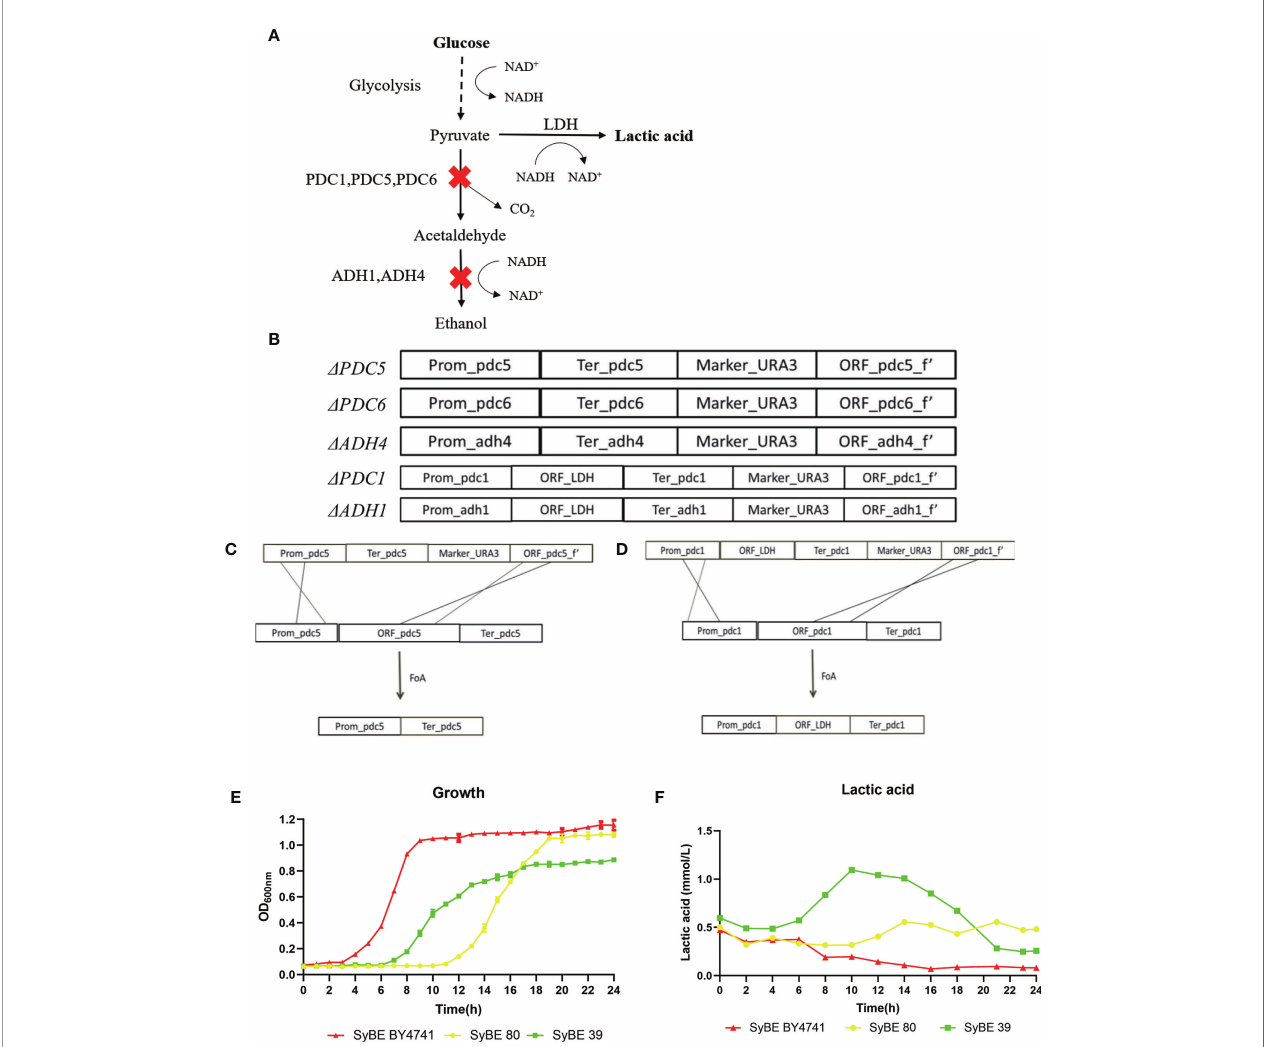
FIGURE 1 | Engineering strategy to improve lactic acid prodution in Saccharomyces cerevisiae . (A) Schematic diagram of engineering S. cerevisiae . (B – D) Processes to knock out the PDC5 and PDC1 genes. (E) Growth curves of the three strains SyBE BY4741, SyBE 80, and SyBE 39. (F) Lactic acid production of the strains SyBE BY4741, SyBE 80, and SyBE